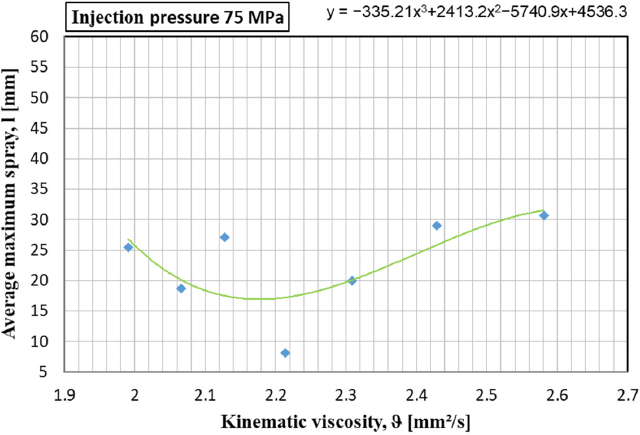
Figure 9. Maximum range of spray tip with the trend line determined for injection pressure of 75 MPa.